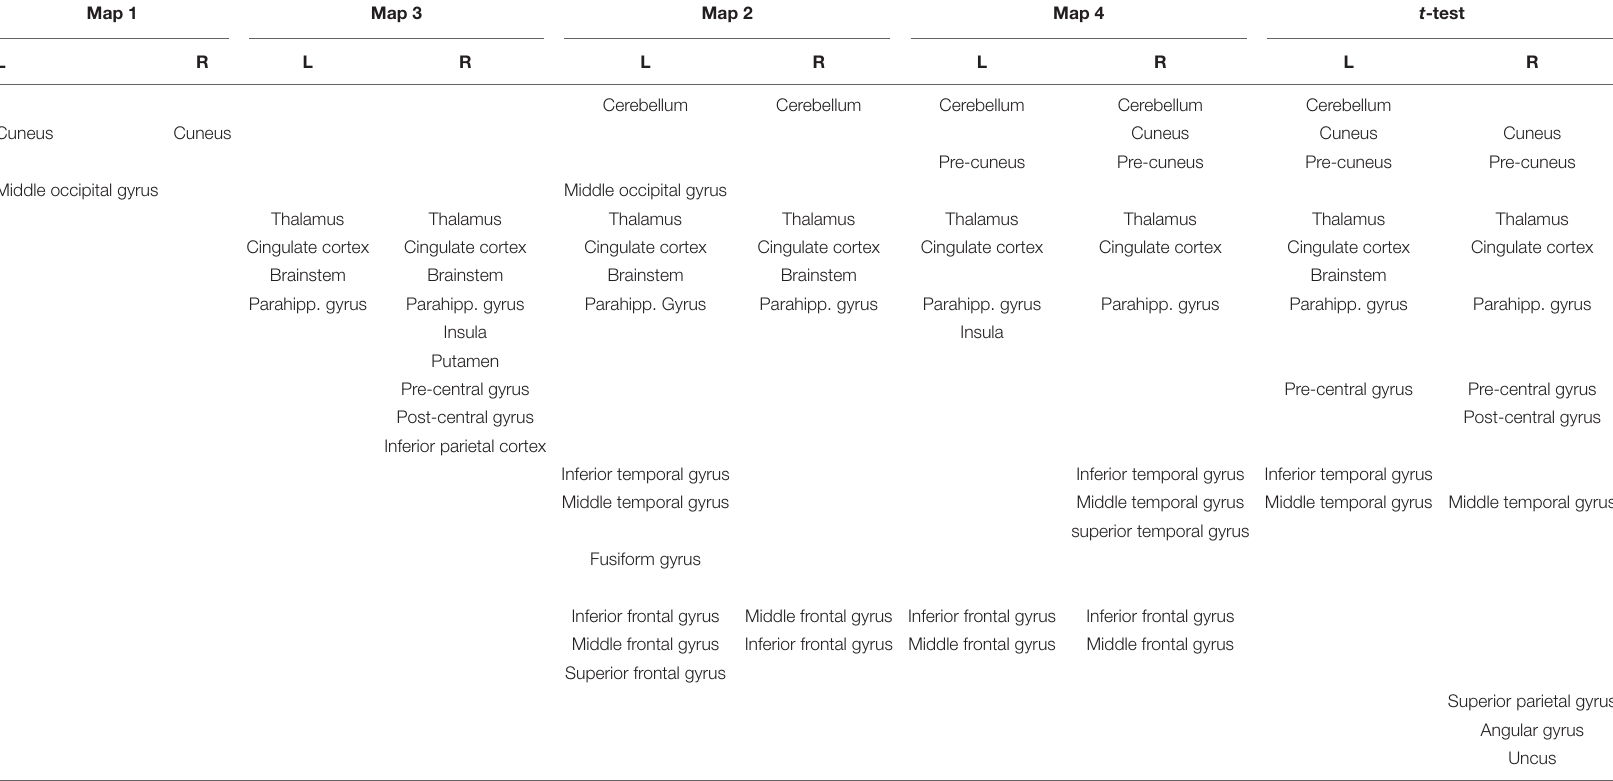
Note that the map order corresponds to the respective backfit: maps